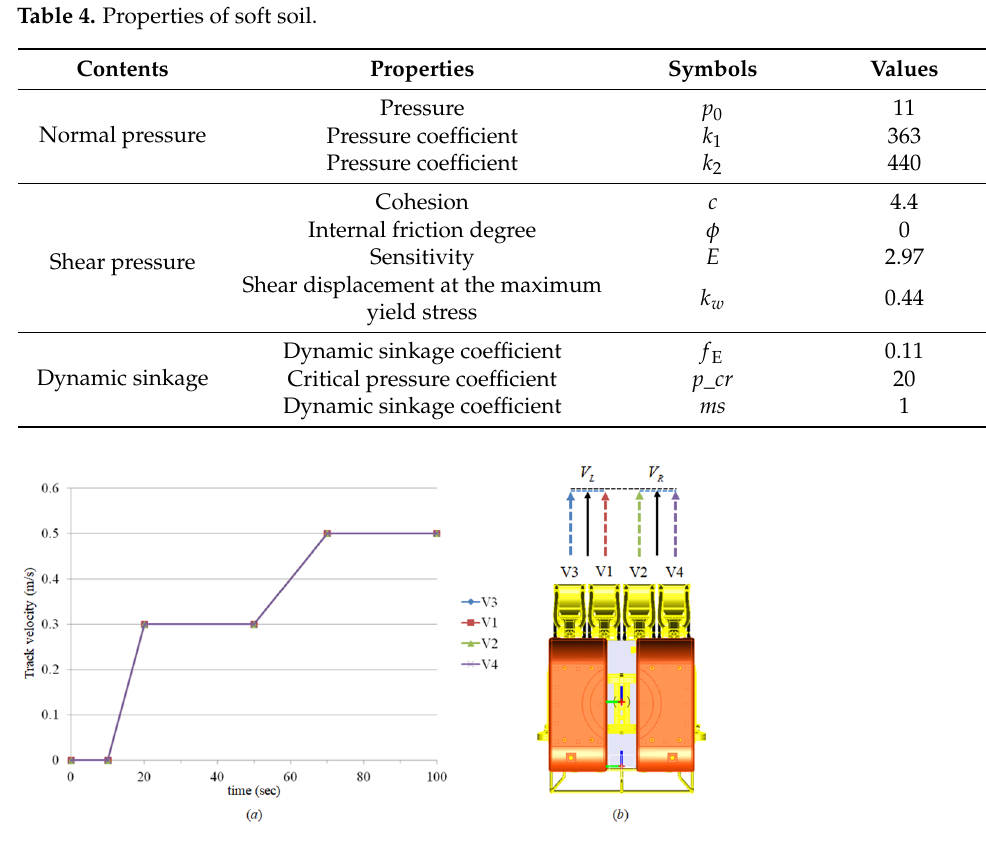
Figure 26. Track input speed and steering ratio of a mining robot for straight driving: ( a ) input speed of each track row, ( b ) definition of track row ID and steering ratio calculation method (Top view of mining robot).